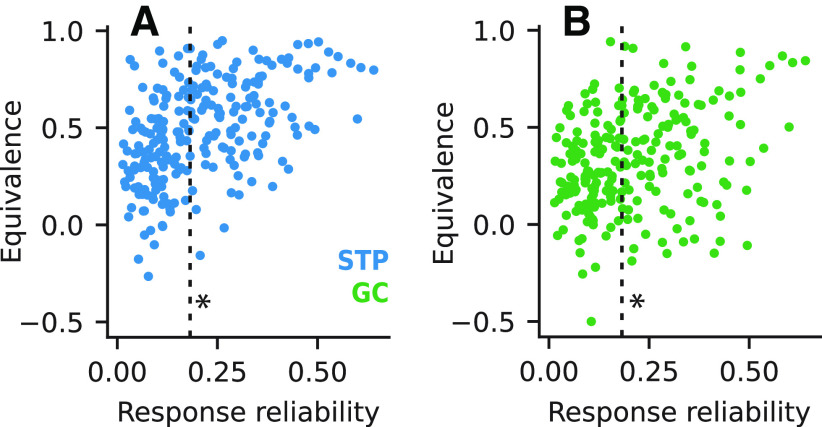
Within-model equivalence ordered by response reliability. A, Scatter plot compares within-model equivalence scores for the STP model compared with response reliability (n = 237 neurons recorded with the larger stimulus set). Dashed line indicates median reliability. Within-model equivalence was significantly higher for neurons with above-median reliability (median high reliability: 0.61, low reliability: 0.36, Mann–Whitney U test, *p = 6.01 × 10−12). B, Within-model equivalence scores for the GC model versus reliability, plotted as in A. Again, within-model equivalence was significantly higher for neurons with above-median reliability (median high reliability: 0.42, low reliability: 0.25, *p = 3.91 × 10−5).